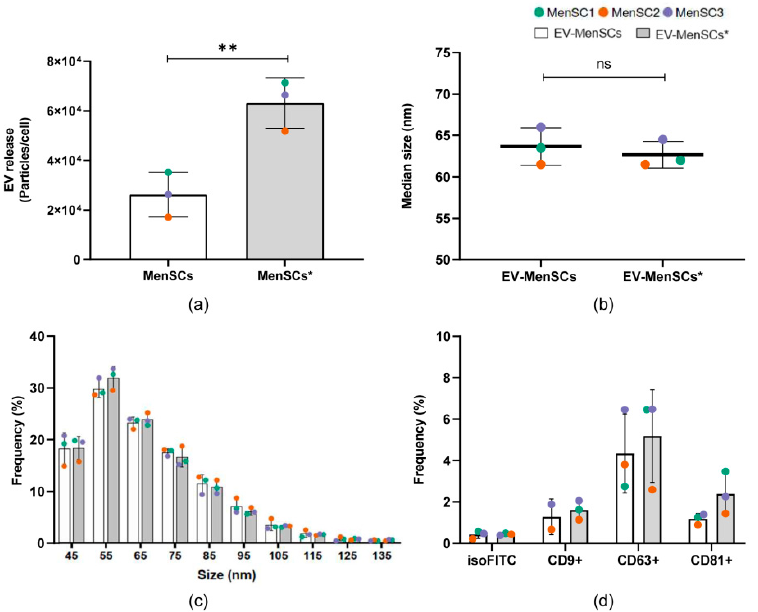
Figure 3. Characterization of the EV fraction in the secretome of MenSCs. ( a ) EV release rate of MenSC under basal (white bars) and priming (gray bars) conditions. The number of particles released by MenSCs after 96 h was determined for the secretome samples (10,000 × g supernatants) by nFC. Values were normalized to the total number of viable cells. ( b ) Median size (nm) of particles detected in EV-enriched fractions (EV-MenSCs) obtained after size exclusion chromatography (SEC) of the secretomes. ( c ) Histogram of particle size (SEC samples) with a bin width of 10 nm from primed (gray bars) and basal (white bars) MenSCs. Mean ± SD of the relative frequency of total events detected by nFC is shown. ( d ) Single-particle phenotyping of EV samples obtained by SEC. Three tetraspanin markers (CD9, CD63, and CD81) were evaluated by single-vesicle fluorescence analyses. Only those samples which showed positive staining were plotted. Different colored dots represent the values obtained with independent donors ( n = 3). Significance was tested by a paired t -test. ** p < 0.01 in primed vs. basal